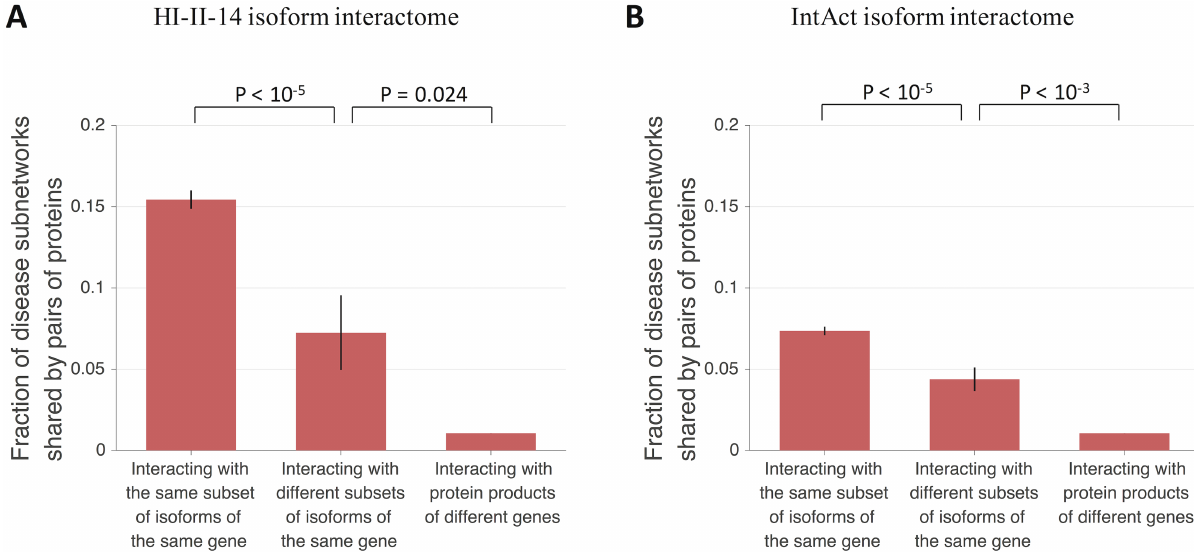
Fig 3. Fraction of shared disease subnetworks for protein pairs with different types of isoform interaction profiles. (A) Fraction of shared diseasesubnetworksfor pairs of proteins interacting with the same subset of isoforms of the same gene, with different subsets of isoforms of the same gene, and with protein products of different genesin the predicted HI-II-14 isoform interactome. (B) Fraction of shared disease subnetworks for pairs of proteins interacting with the same subset of isoforms of the same gene, with different subsets of isoforms of the same gene, and with protein products of different genesin the predictedIntAct isoform interactome. Fraction of shared disease subnetworkswas calculatedusing the Jaccard similarity index. Only pairs in which both proteins are associated with at least one disease subnetworkwere considered.A protein belongs to a diseasesubnetworkif that protein or any of its first-degreeneighborsin the HI-II-14 reference binary interactome are associated with the disease.Error bars represent standarderrors of the mean. Statistical significancewas calculatedusing a